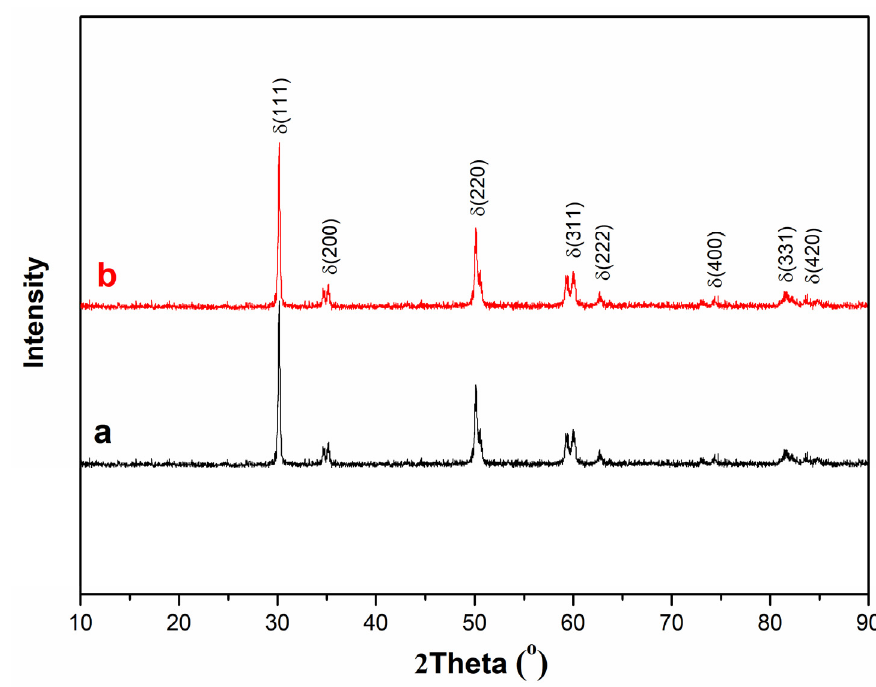
Figure 3. XRD patterns of GDZ-8 samples for the ( a ) powder and ( b ) pellet samples.